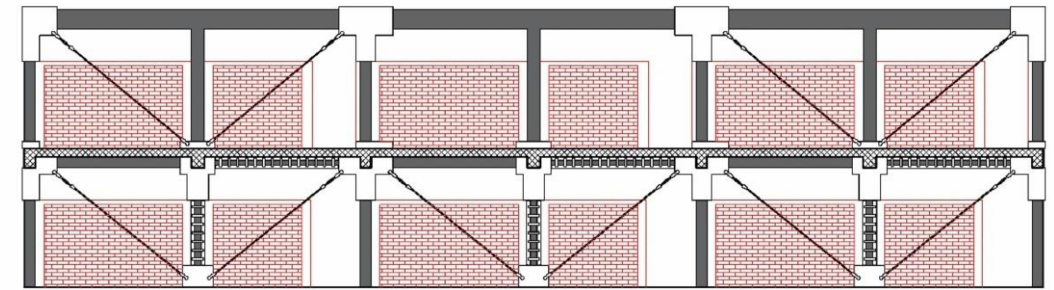
Figure 7. PREbuilding type: schematic view for the retrofitting intervention A 4